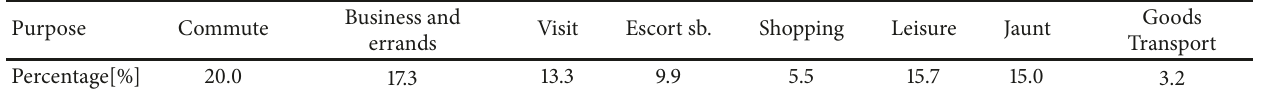
Table 5: Main trip purpose of car-sharing